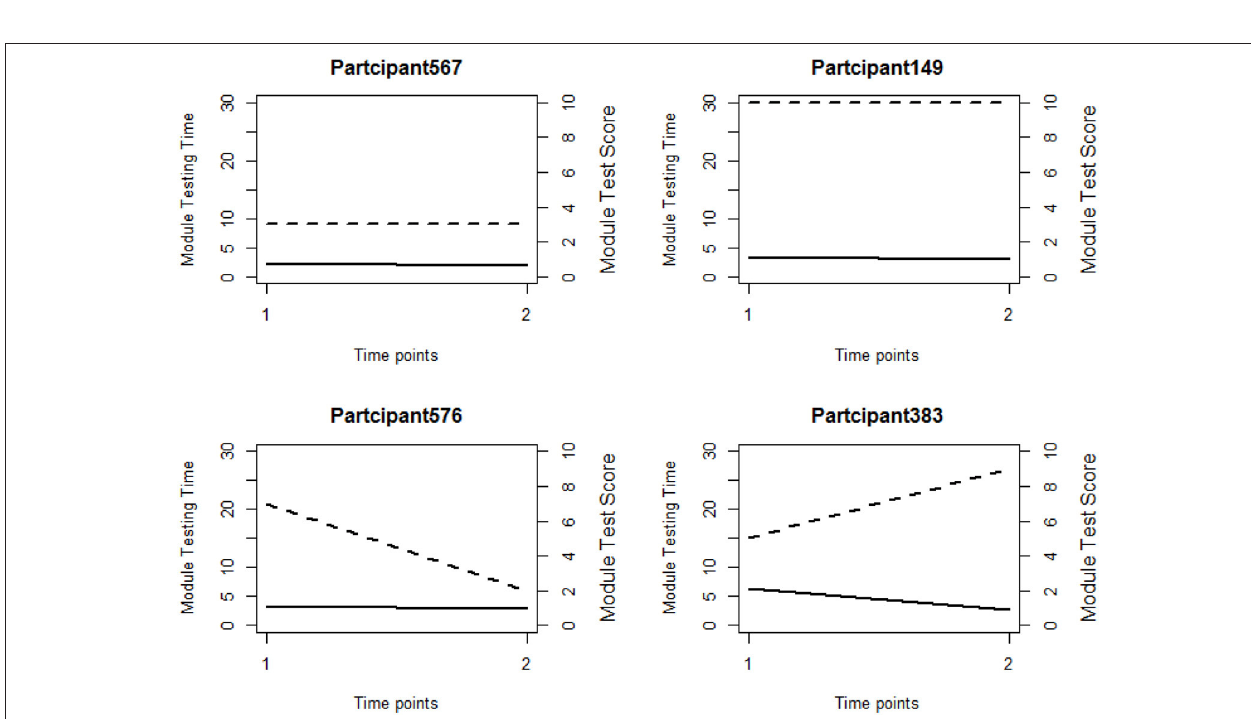
FIGURE 3 | Line plots of four participants’ testing time and module scores in module 1 and module 4. The dashed line and solid line represent module score and testing time respectively. Time point 1 represents module 1 and Time point 2 represents module 4.